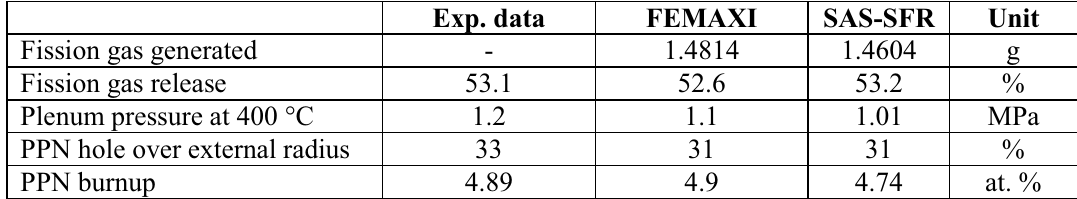
Table II. EOI state for the OPHELIE-6 pins: Experimental vs. FEMAXI vs. SAS-SFR